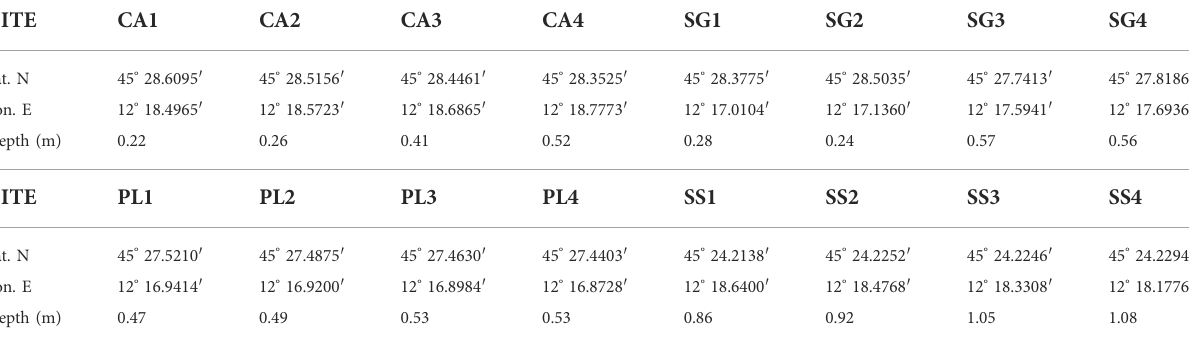
TABLE 2 Coordinates in the WGS84 reference system and bathymetric height of the 16 sites; the latter refers to the zero-tide level recorded by the Punta Salute tide gauge (PS, Figure 1).